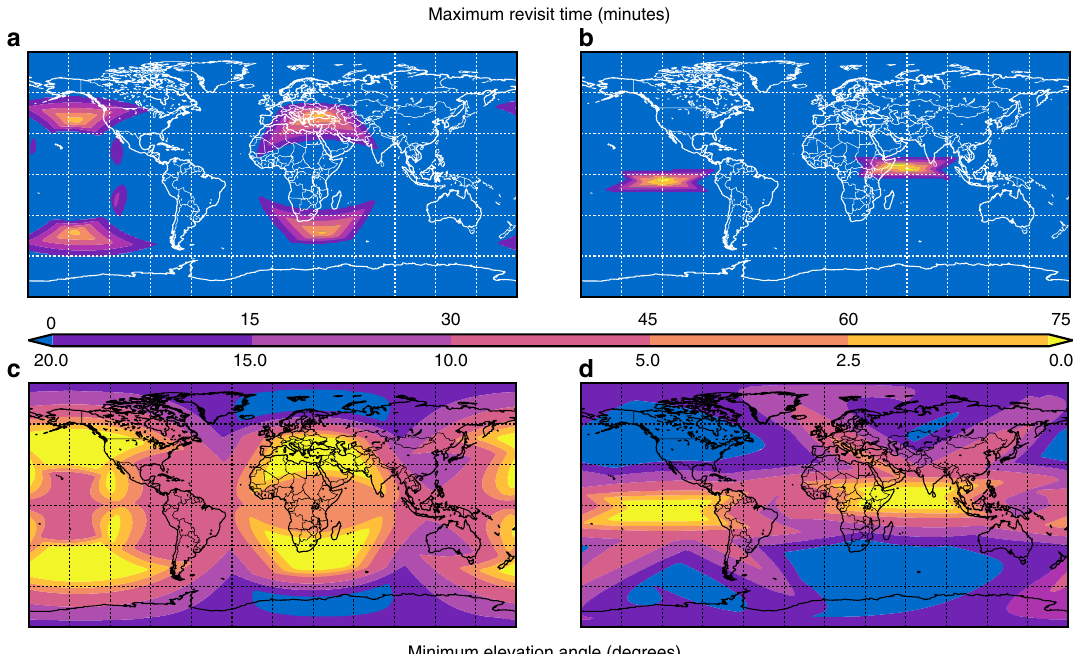
Fig. 1 Maximum revisit time and minimum elevation angle. a Maximum revisit time for the 24-h constellation. b Maximum revisit time for the 48-h constellation. c Minimum elevation angle for the 24-h constellation. d Minimum elevation angle for the 48-h constellation. The top color scale represents maximum revisit time from 0 to 75 min. The bottom color scale represents minimum elevation angle from 0 to 20 (cid:1) . The x and y axes are longitude and latitude,